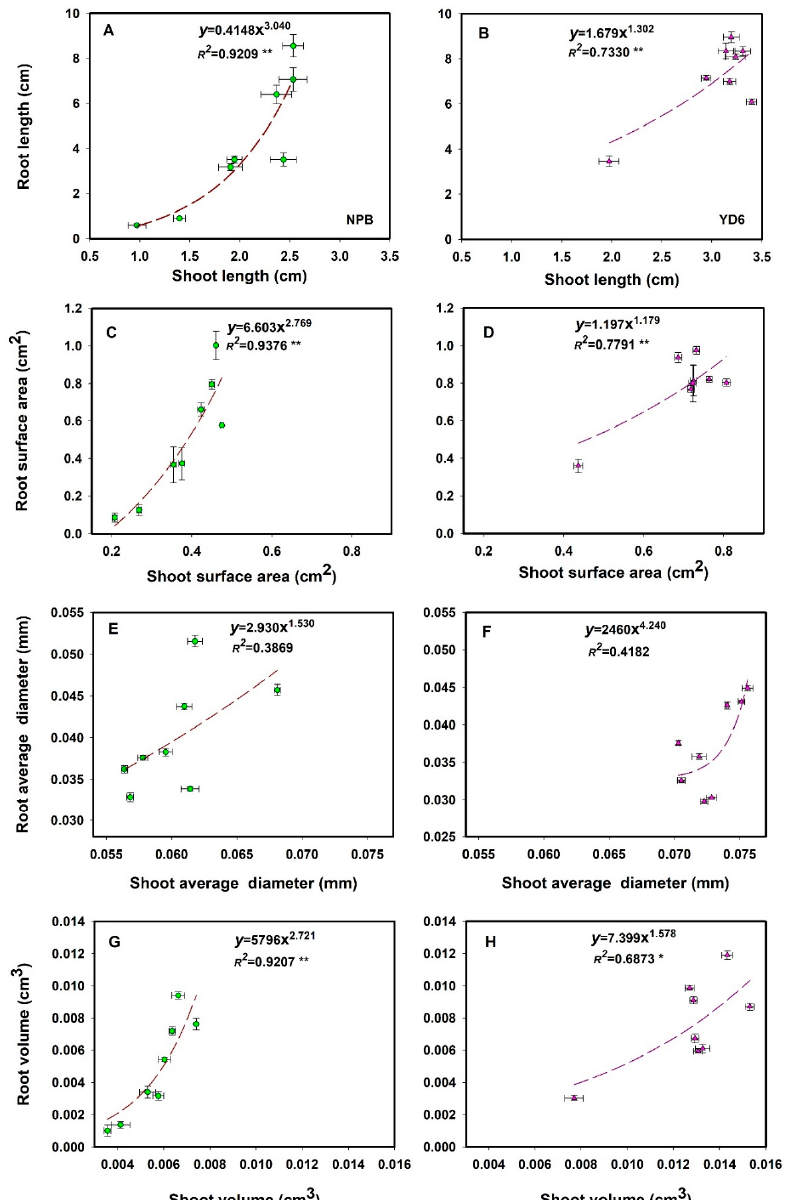
Figure 2. Correlation between four indices of shoot and root at different irradiation dose (0 Gy, 50 Gy, 100 Gy, 150 Gy, 250 Gy, 300 Gy, 400 Gy and 500 Gy) in japonica rice NPB and indica rice YD6. Three biological replicates and each biological replicate contains one hundred seeds. * ( p ≤ 0.05), ** ( p ≤ 0.01) represent significance level.